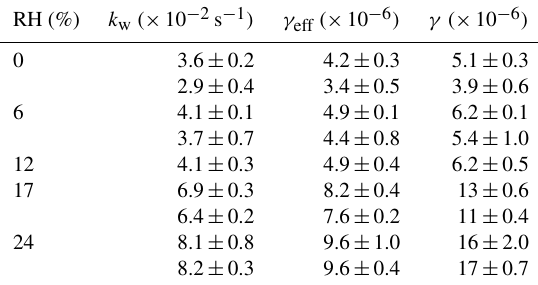
Table 1. Loss rates ( k w ) , effective uptake coefficients ( γ eff ) and true uptake coefficients ( γ) of ClONO 2 onto the inner wall of the Pyrex tube at different relative humidities (RHs). Measurements were all carried out with initial ClONO 2 mixing ratios of several hundred